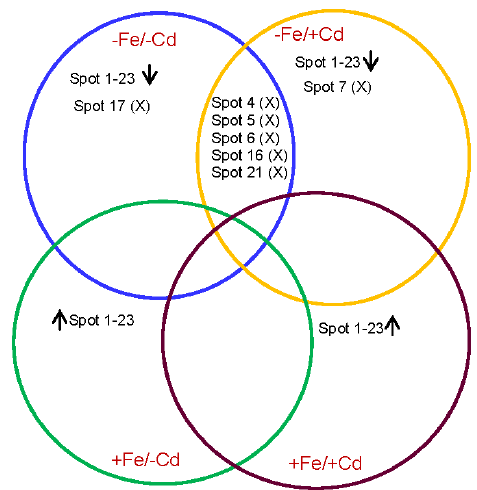
Figure 4. Venn diagram showing differential expression of root proteins of green gram under four combined Fe and Cd treatemnet. Numbers correspond to the protein spots present in 2DE patterns of +Fe/+Cd, −Fe/−Cd, −Fe/−Cd and +Fe/+Cd. The overlapped portions with “X” denote commonly absent proteins. Upward and downword arrows denote increased or decreased protein expression under four